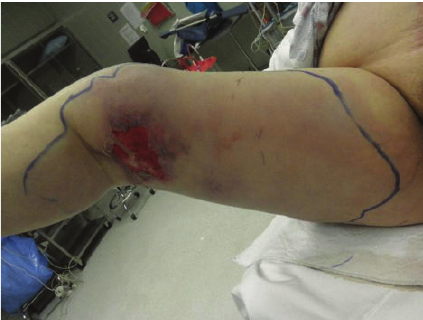
Figure 1: Preoperative photograph on the day of admission showing rapidly progressive painful extensive erythema, blistering, ulcera- tion, edema, and skin necrosis of the right leg due to necrotizing soft tissue infection.